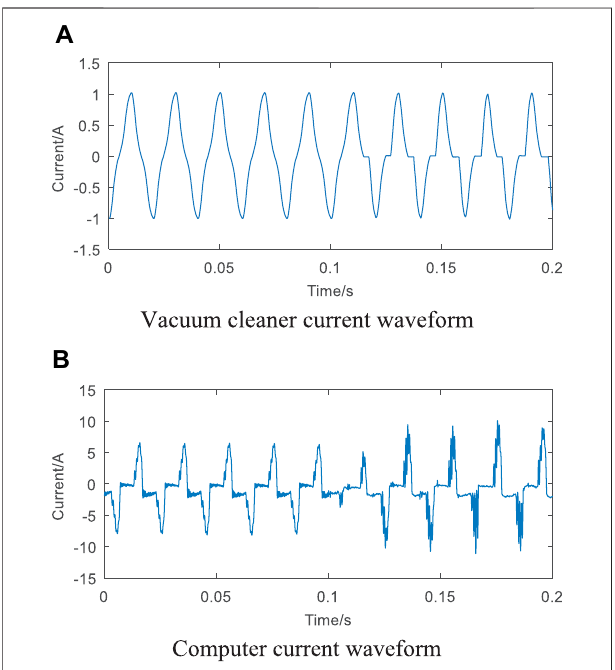
FIGURE3| Typicalload normal and fault currentwaveform. (A) Vacuum cleaner current waveform. (B) Computer current